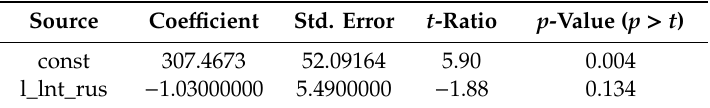
Table 1. Regression analysis data of the relationship between the value of intangible assets ( x 2 ) and the capitalization of Russian companies.